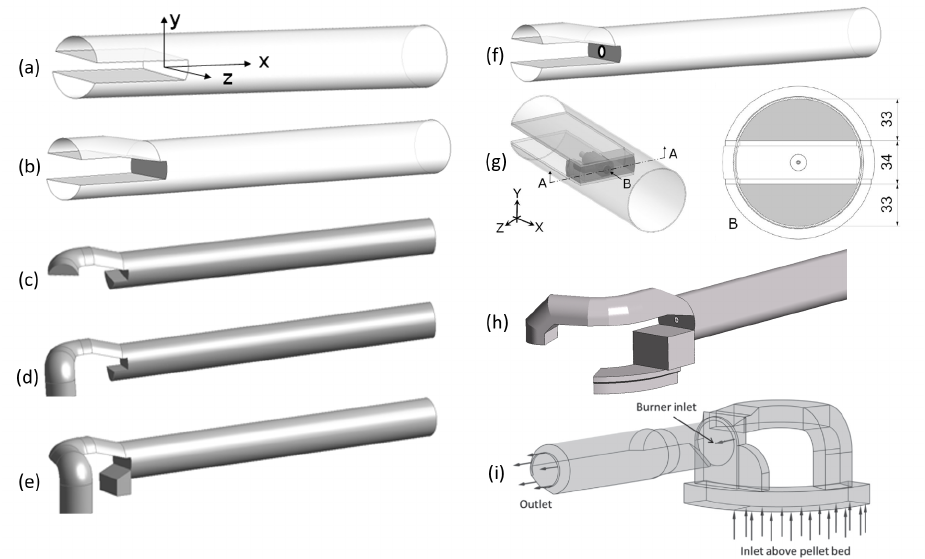
Figure 3. Geometries studied in the project: ( a – e ) only secondary flow, no burner jet and ( f – i ) burner jet included. ( f ) Single jet, ( g ) coaxial jets, ( h ) pilot-scale with coal combustion, ( i ) kiln with different type of hood, no backplate present. Figures adapted from